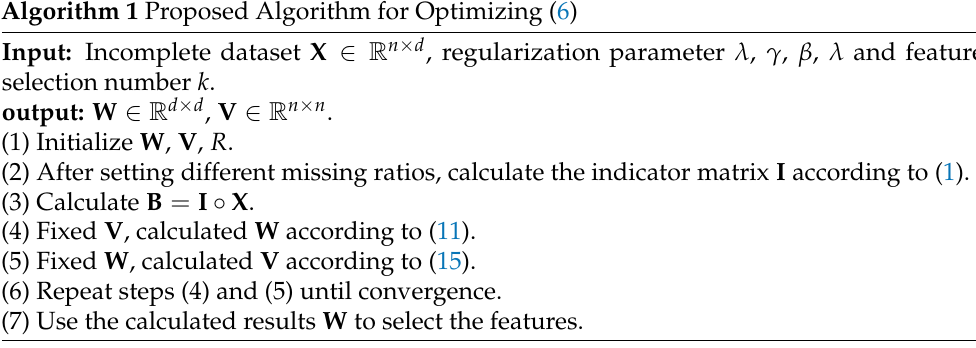
Algorithm 1 Proposed Algorithm for Optimizing